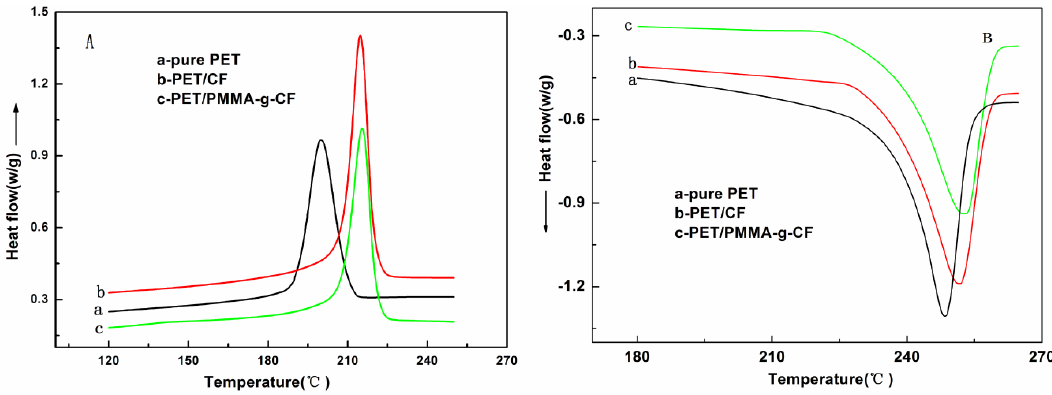
Figure 9. DSC ( A ) cooling and ( B ) the second heating thermograms of PET, PET/CF, and PET/PMMA- g-CF composites. Table 3. Summary of thermal properties of PET, PET/CF, and PET/PMMA-g-CF composites. Sample